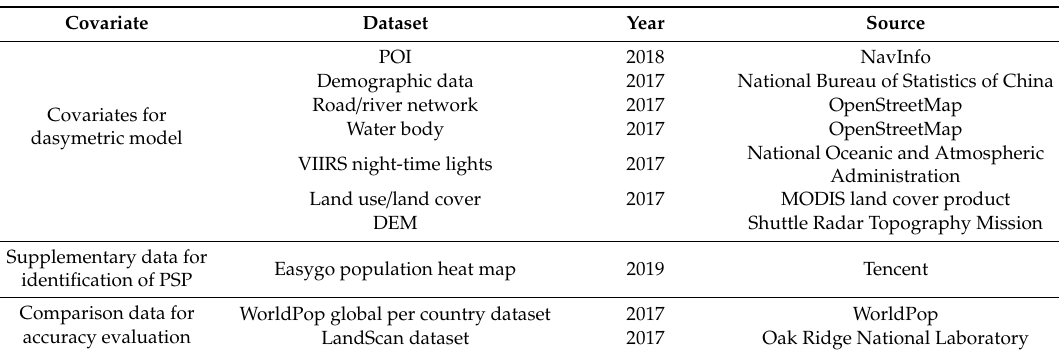
Table 1. Datasets used in this